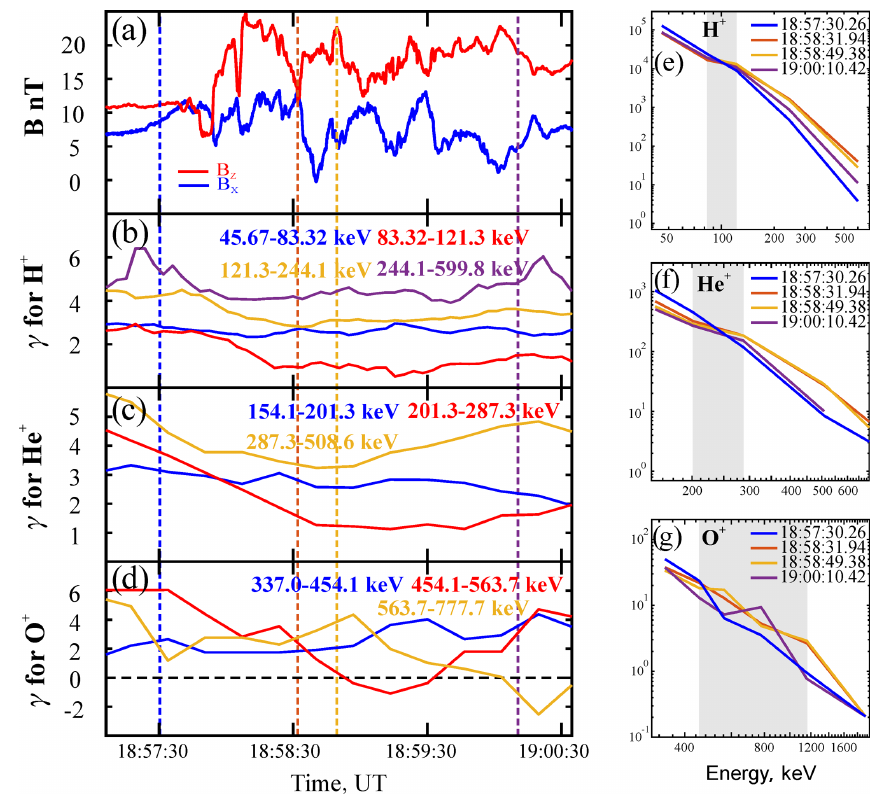
Figure 2. Variations of spectral index γ calculated for H + (b) , He + (c) and O + (d) ion components in the energy ranges indicated in the corresponding panels. Panel (a) shows the time profiles of B X and B Z field for reference. Vertical dashed colored lines indicate the time moments at which energy spectra of H + , He + and O + ions are plotted in panels (e) – (d) respectively. The gray-shaded areas in panels (e) – (d) display the energy ranges at which the peculiarities (flattening or bulges) are observed in the energy